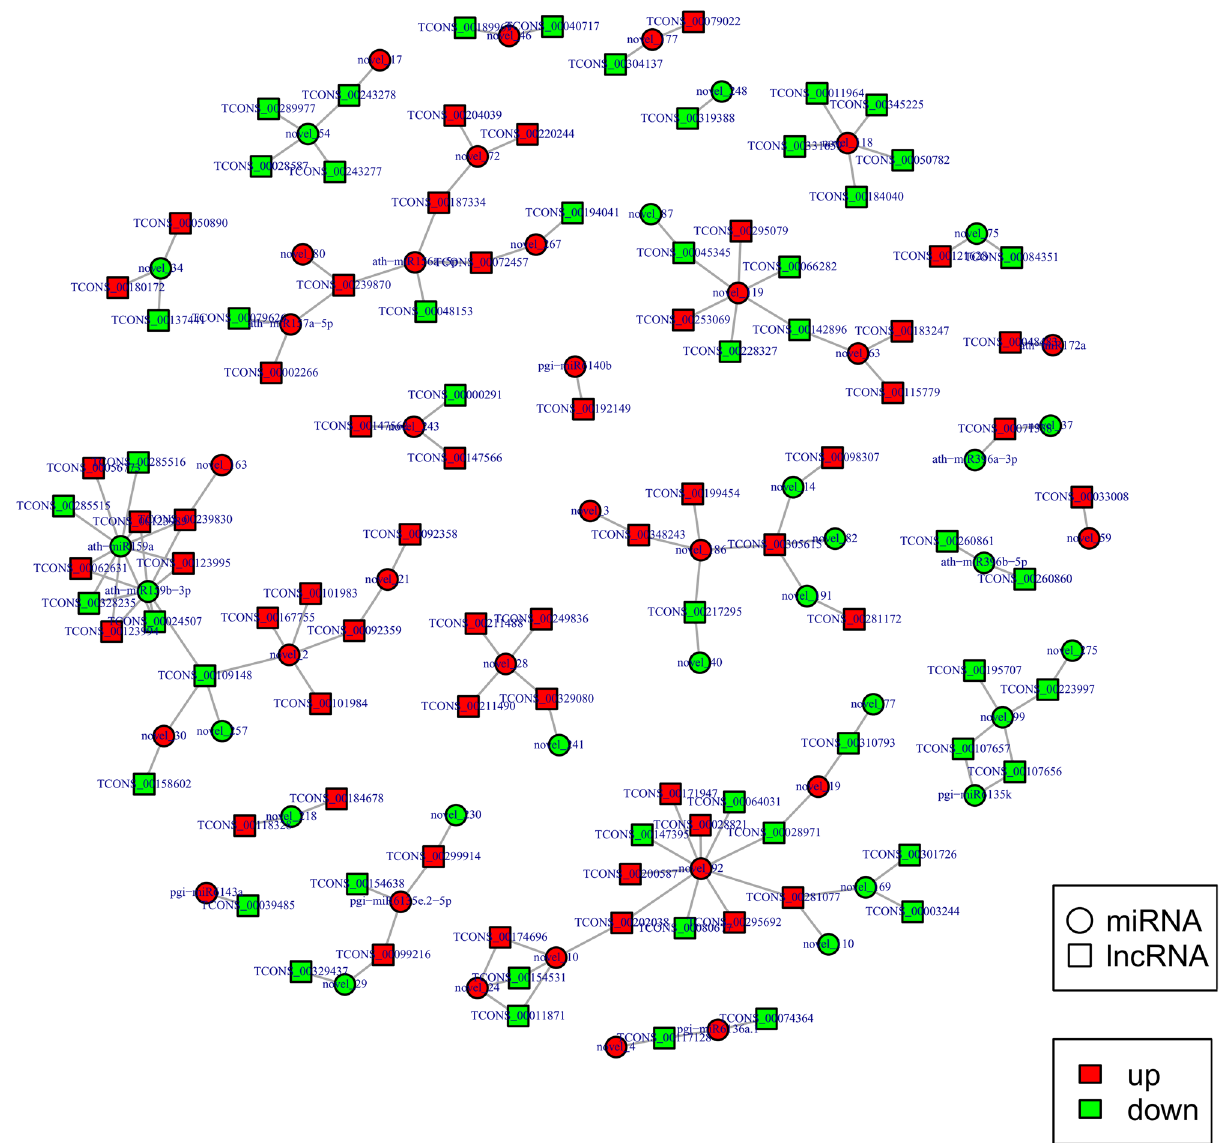
Figure 12. Interaction network of miRNA-lncRNA in ginseng tissues. Network diagram made by Cytoscape sofware 3.8.2 (https:// cytos cape. org/) 57